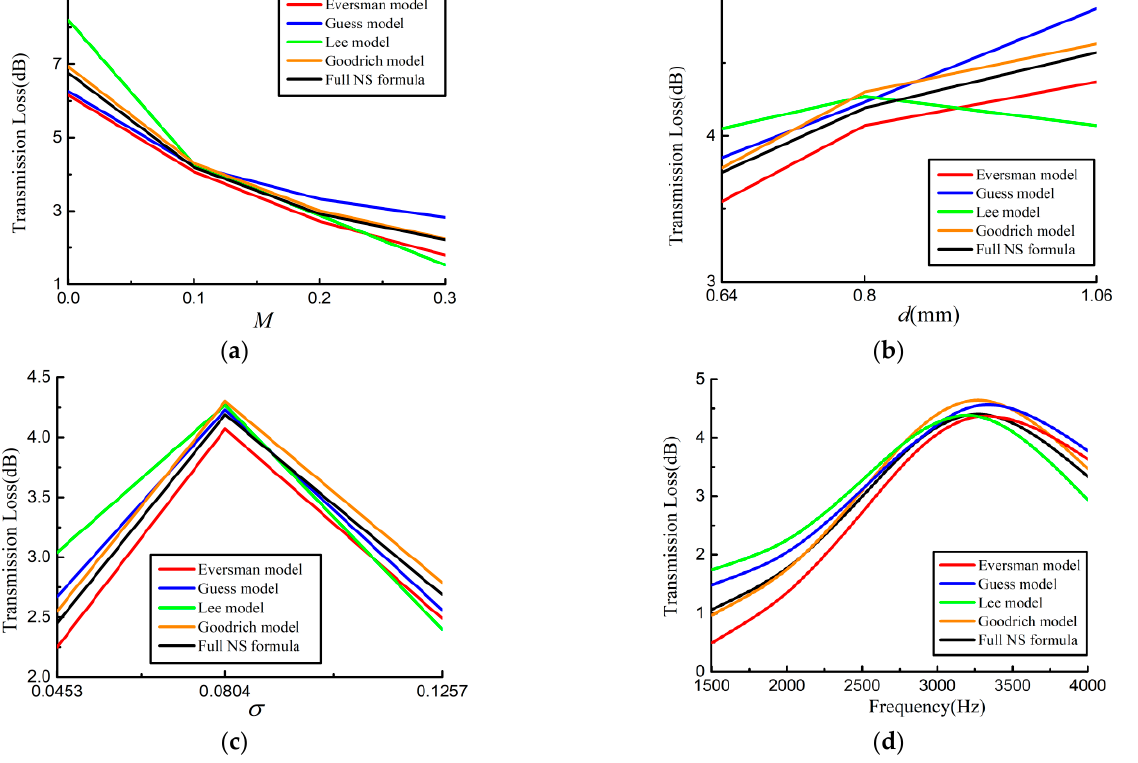
Figure 7. Comparisons of transmission loss using different impedance models. ( a ) Different Mach number; ( b ) different hole diameters; ( c ) different perforation rates; ( d ) different frequencies.